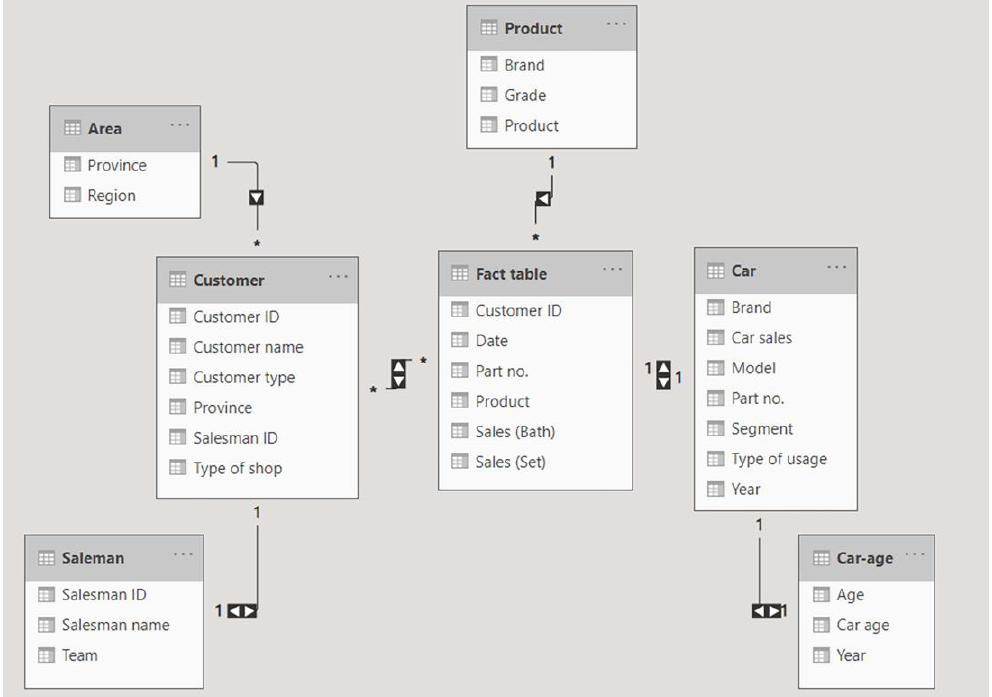
Figure 2. Snowflake schema structure. The notations (*:1) and (1:*) represent many-to-one and one-to-many relationships, respectively. The notation (1:1) indicates a one-to-one relationship.